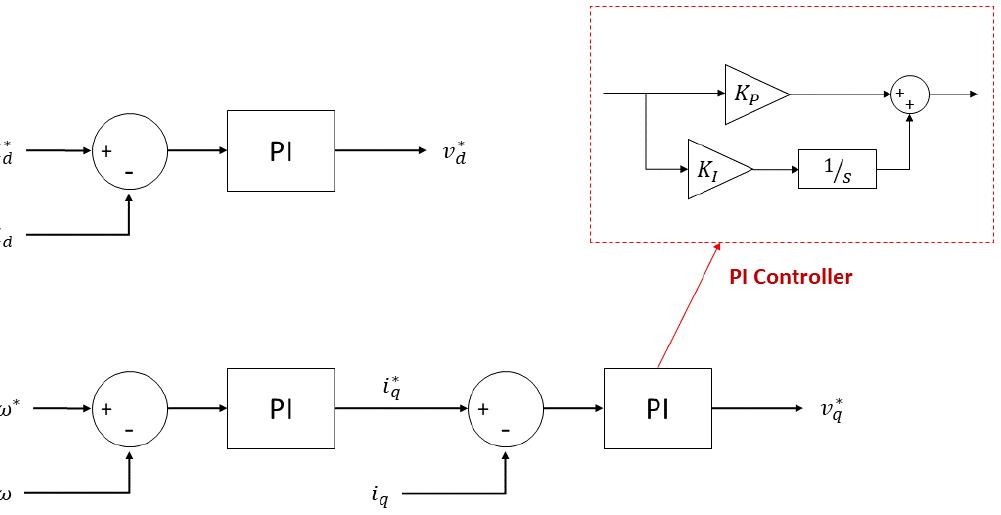
Figure 2. Linear control architecture for PMSG.